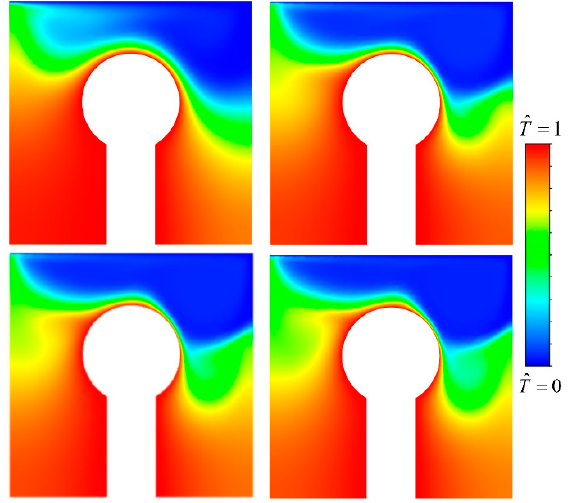
Figure 11. Temperature contours for the C1 fin with Ra = 10 3 for varying Raynolds numbers. From left to right, top to bottom: Re = 100, Re = 500, Re = 750, and Re = 1000.